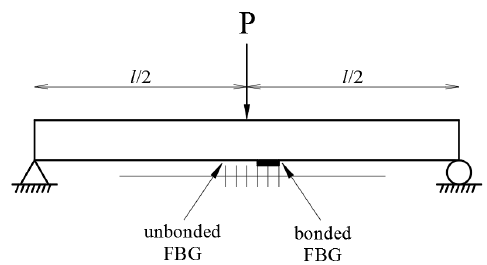
Figure 4. Three-point bending test on an Al specimen with bonded and unbonded FBG.